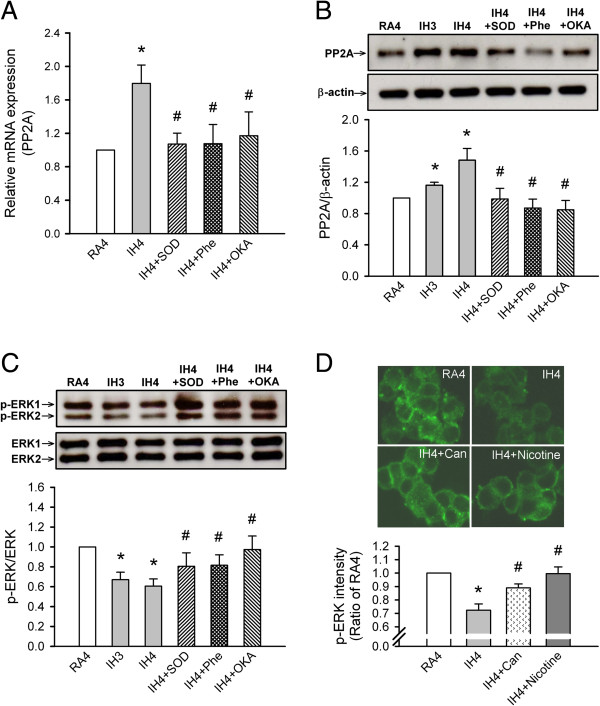
Intermittent hypoxia (IH) effects on protein phosphatase 2A (PP2A) and extracellular signal-regulated kinase 1/2 (ERK1/2) phosphorylation. (A) PP2A mRNA levels were determined by real-time quantitative polymerase chain reaction (qPCR) and (B) PP2A protein levels were determined by Western blot in PC12 cells after 4 days of room air exposure (RA4, n = 7), 3–4 days of IH (IH3, n = 5; IH4, n = 5), and IH4 along with superoxide dismutase (IH4 + SOD, n = 6), 1,10-phenanthroline (IH4 + Phe, n = 5) or okadaic acid (IH4 + OKA, n = 5). (C) ERK1/2 phosphorylation levels in PC12 cells were determined by Western blotting after RA4, IH3, IH4, IH4 + SOD, IH4 + Phe, IH4 + OKA and (D) immunocytofluorescence (green) after RA4, IH4, IH4 along with cantharidin (IH4 + Can, n = 5) and nicotine (IH4 + Nicotine, n = 5). *p < 0.05 compared with RA4. #p < 0.05 compared with IH4. Values are means ± SEMs.